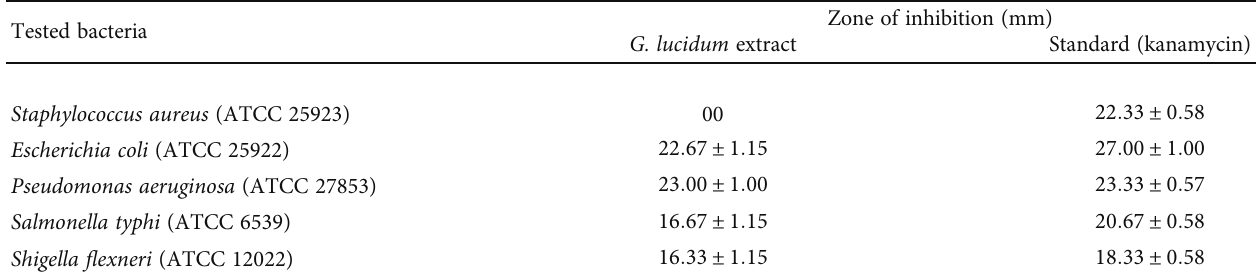
Table 5: Antibacterial activity of G. lucidum